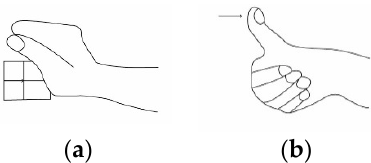
Figure 2. Hand- movements considered for this study. ( a ) Contact-grip ( b ) Distal